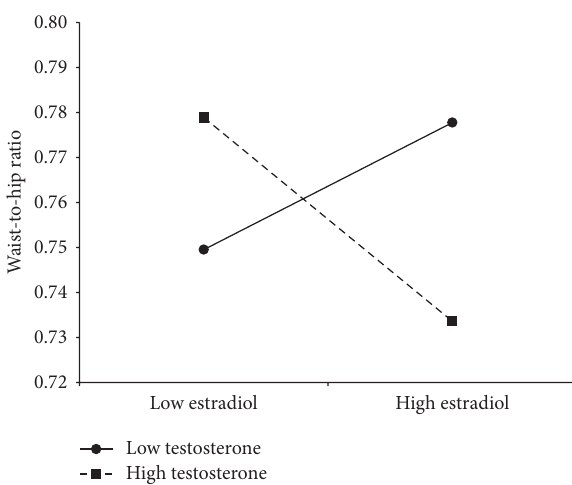
Figure 3: Plot of − 1 SD (low) and +1 SD (high) of testosterone and estradiol levels showing the effect on waist-to-hip ratio of the estradiol × testosterone interaction. Low testosterone levels did not have a significant effect on waist-to-hip ratio as estradiol increased ( 𝑃 = 0.2 ). Conversely, when testosterone was high, waist-to-hip ratio changed significantly from being high at low estradiol levels to low when both steroids’ concentrations were high ( 𝑃 = 0.023